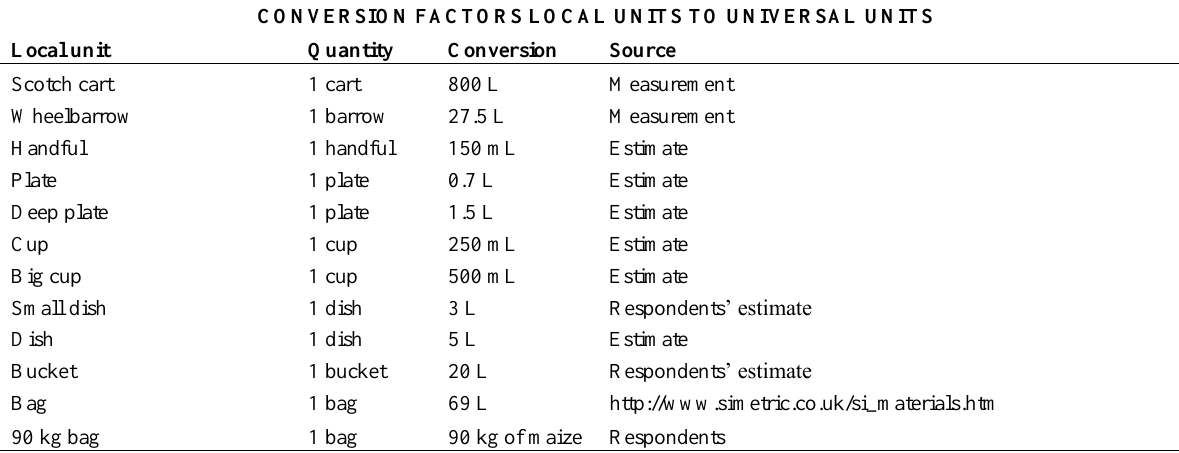
Table A2.3: Conversion factors local units to universal units CONVERSION FACTORS LOCAL UNITS TO UNIVERSAL